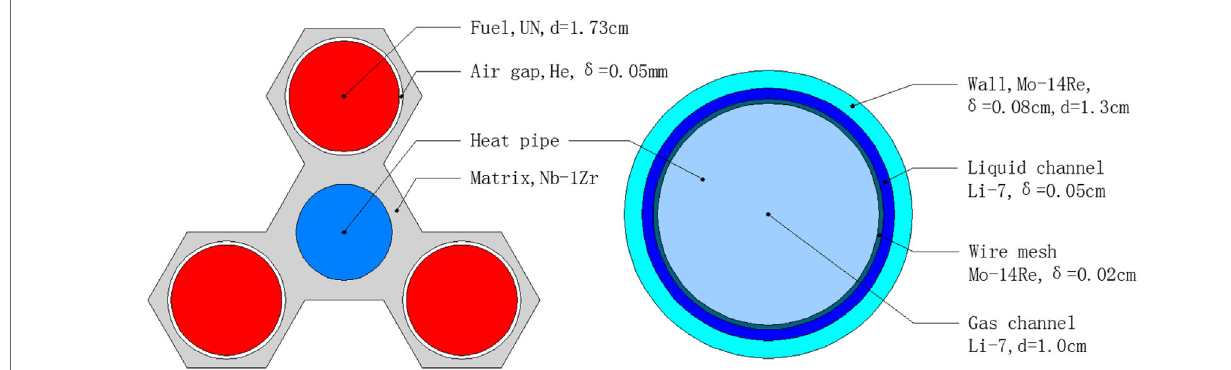
FigUre 3 | Design of fuels and heat pipes.